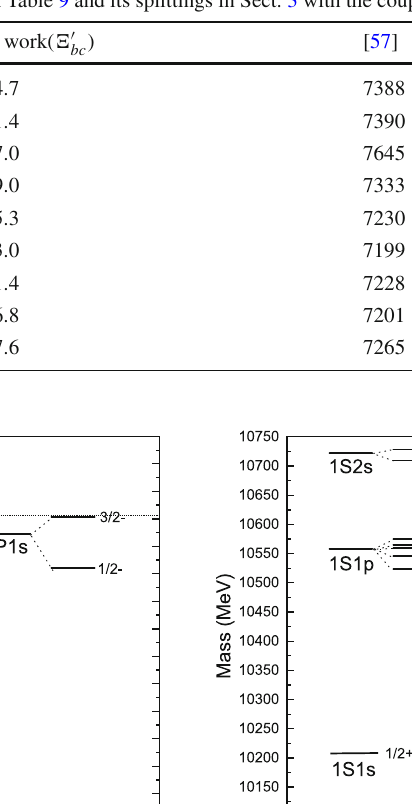
/(cid:3) (cid:2) in Table 3, bc bc